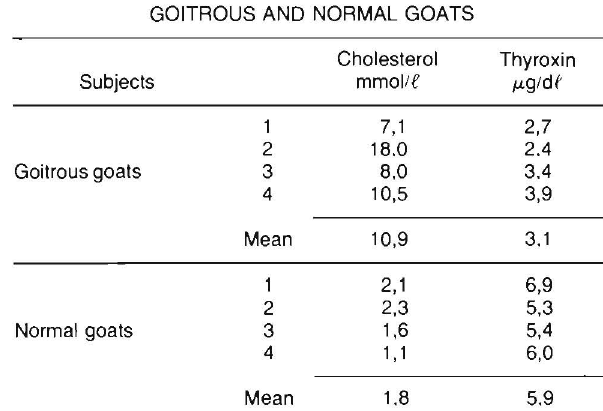
Table 1: PLASMA CHOLESTEROL AND THYROXINE LEVELS IN GOITROUS AND NORMAL GOATS Cholesterol